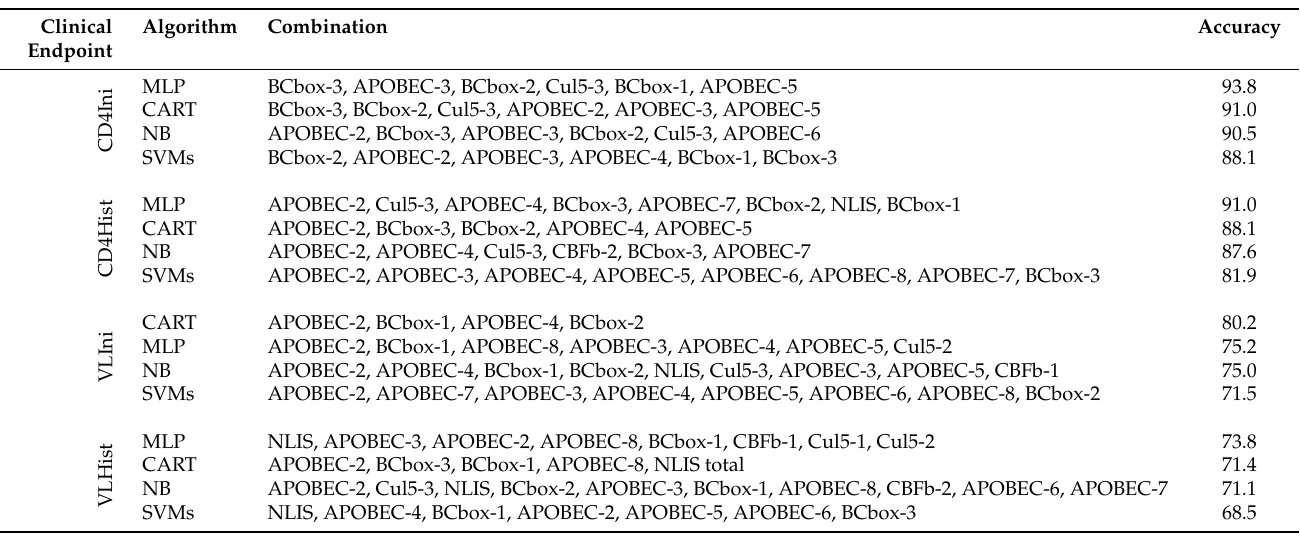
Table 2. Best classification performance achieved by each algorithm, considering 100 balanced datasets for each clinical endpoint. These combinations were used for calculating the variables scores with the MAREV-2